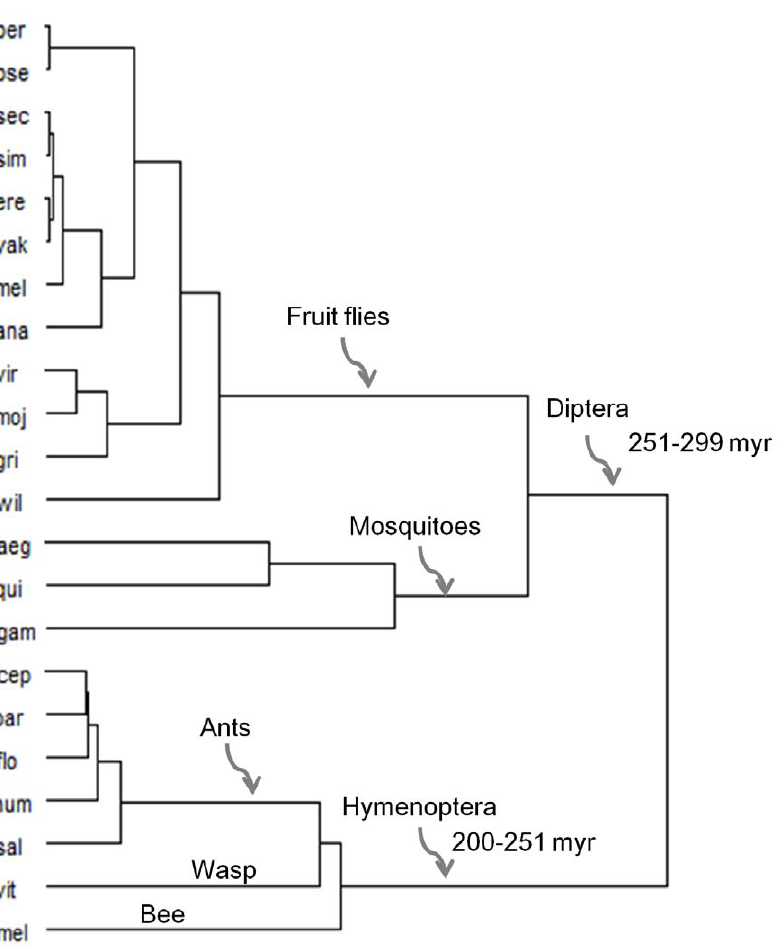
Figure 4. A cluster tree depicting codon context variation among insects. The species names are shown as 4 letter abbreviations. The clusters of codon context variation and their association with insect orders have been indicated. The divergence times (in million years from now) of Diptera and Hymenoptera orders are also shown.